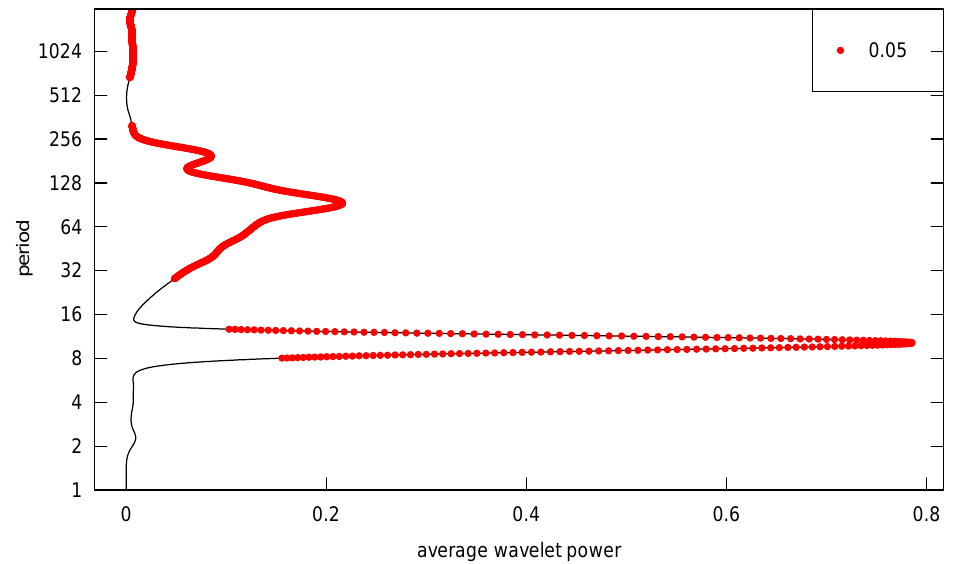
Figure 8. Plot of wavelet power averages across time. The red bullets show the significance level (0.05).